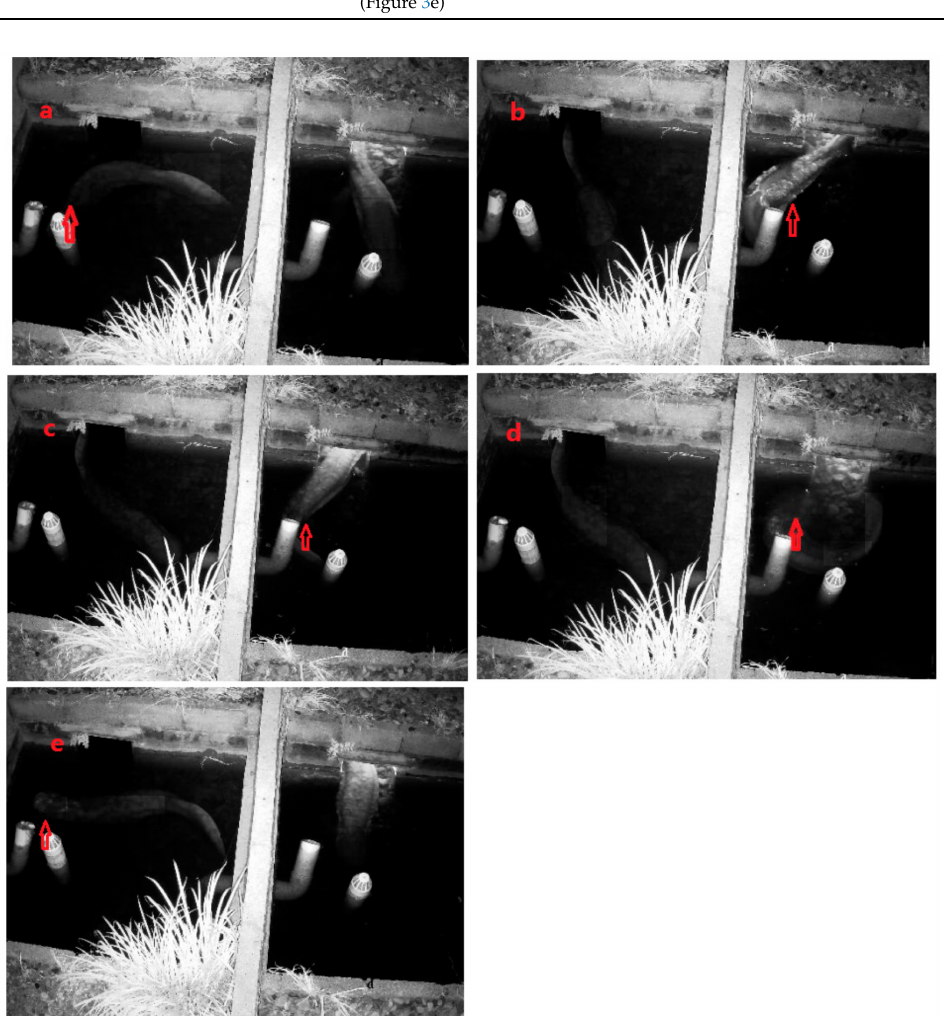
Figure 3. Showering behavior of a male A. davidianus : ( a ) head; ( b ) trunk; ( c ) tail; ( d ) curve; and ( e )